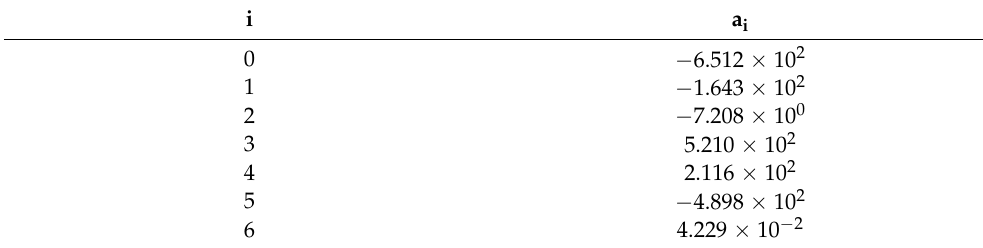
Table A21. Coefficients of the H 2 O-LiCl + LiNO 3 enthalpy equation.